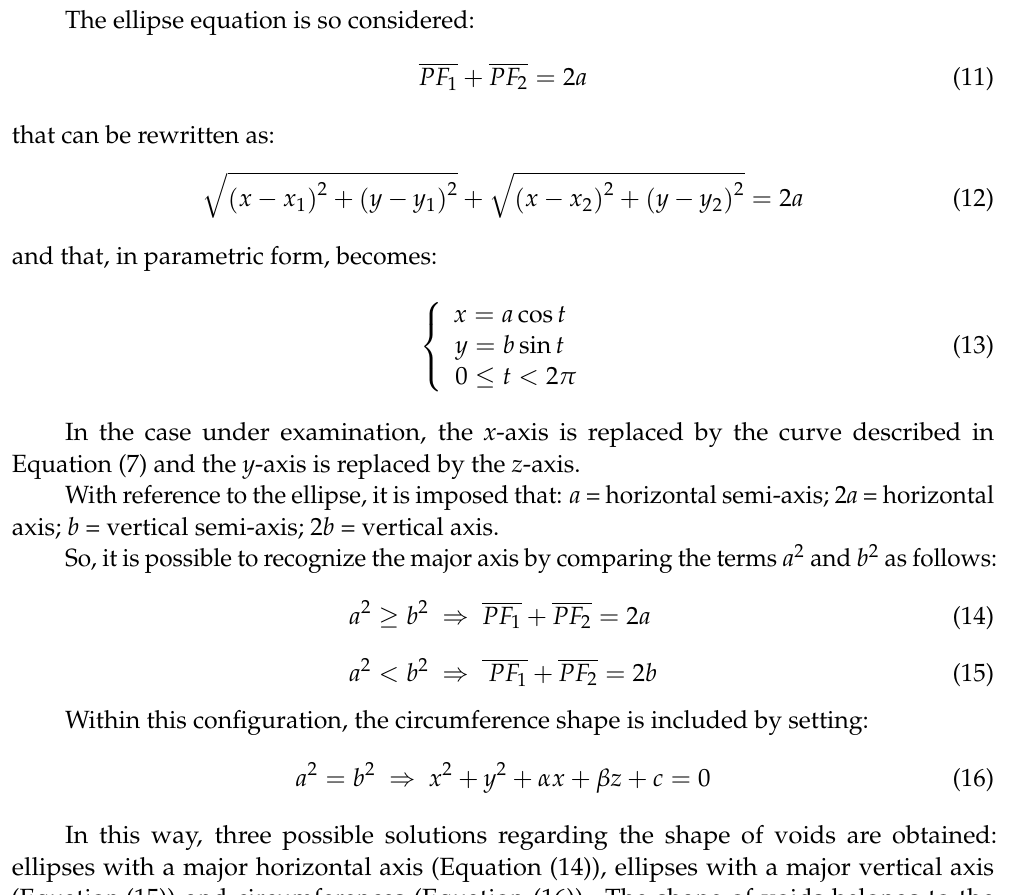
𝑐𝑐 ∈ [ 𝑐𝑐 𝑚𝑚𝑖𝑖𝑚𝑚 ; 𝑐𝑐 𝑚𝑚𝑚𝑚𝑚𝑚 ] (18) Figure 7. Distance between Void N.1 and arch of the circumference. The following relation between the parameters 𝑎𝑎 , 𝑏𝑏 , and ℎ 𝑚𝑚 ′ can so be derived: ℎ 𝑚𝑚 ′ ∈ [0, ℎ 𝑒𝑒 − 𝛿𝛿 ] ⇒ 𝑎𝑎 2 < 𝑏𝑏 2 ⇒ 𝑃𝑃𝐹𝐹 1 ����� + 𝑃𝑃𝐹𝐹 2 ����� = 2 𝑏𝑏 (19) ℎ 𝑚𝑚 ′ ∈ [0,0] ⇒ 𝑎𝑎 2 > 𝑏𝑏 2 ⇒ 𝑃𝑃𝐹𝐹 1 ����� + 𝑃𝑃𝐹𝐹 2 ����� = 2 𝑎𝑎 By using the PlaneTrimCurve component (Pufferfish-Grasshopper plug-in), it is pos- sible to trim the curve described in Equation (14), along the z -axis, obtaining the first de- finitive parametric void at the beam extremity (Figure 8).